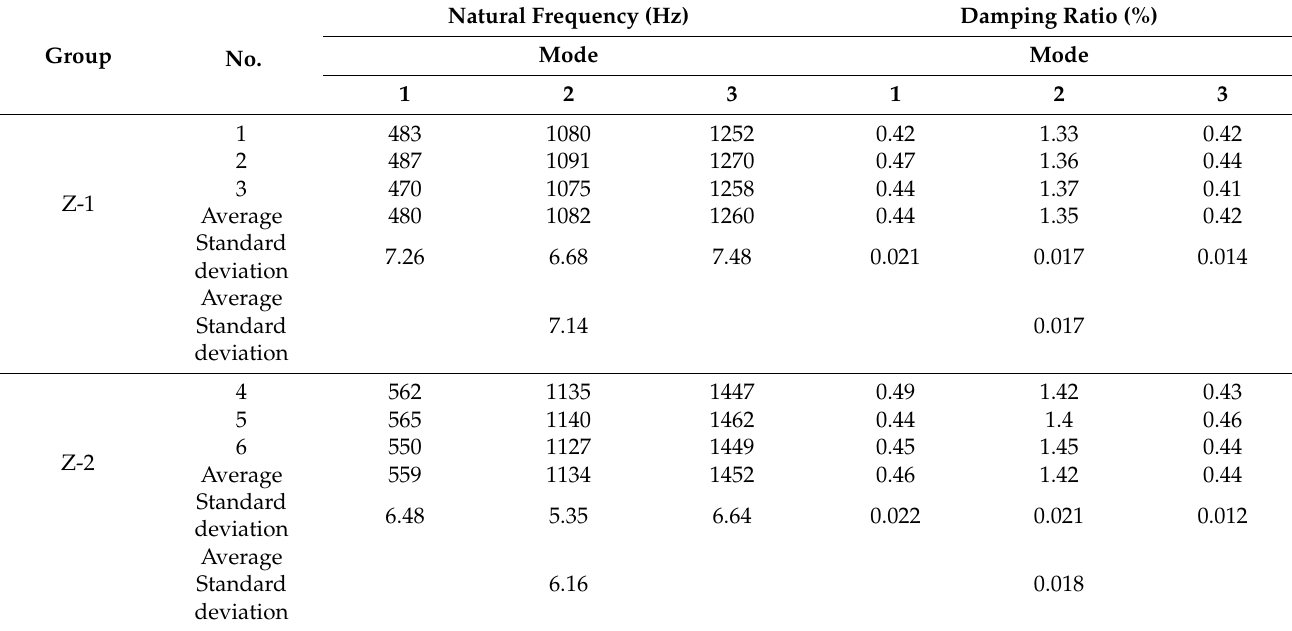
Table 7. Standard deviation of testing